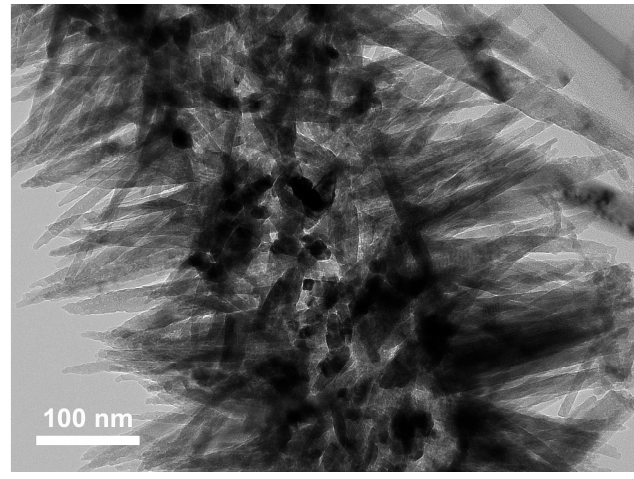
Figure 6. TEM image of B-ZnO NW prepared in 0.08 M NaOH solution at 25 °C for 24 h.